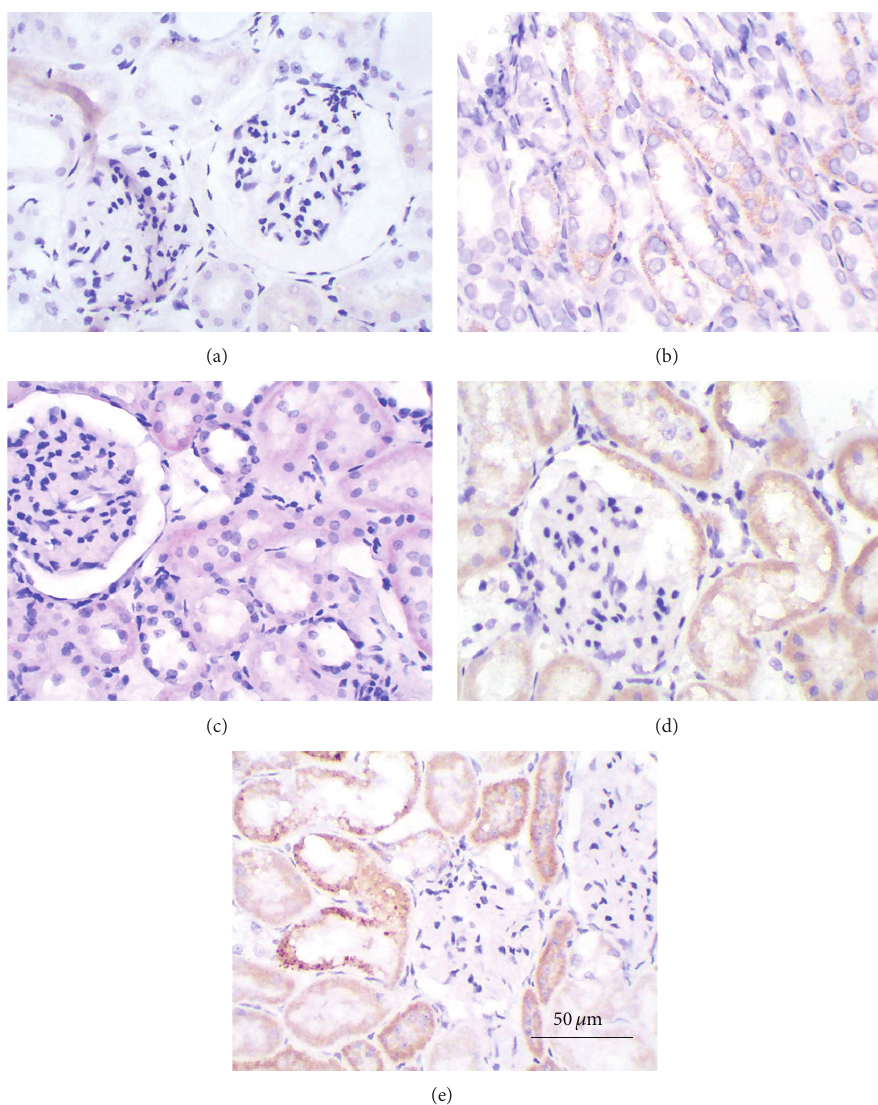
Figure 3: The immunohistochemical staining of kidney (HE 400x) in five groups. (a) Normal control group; (b) diabetic nephropathy control group;(c)benazepril(10 mg/kg/d);(d)irbesartan(30 mg/kg/d);and(e)benazepril(10 mg/kg/d)andirbesartan(30 mg/kg/d);scalebar,50 𝜇